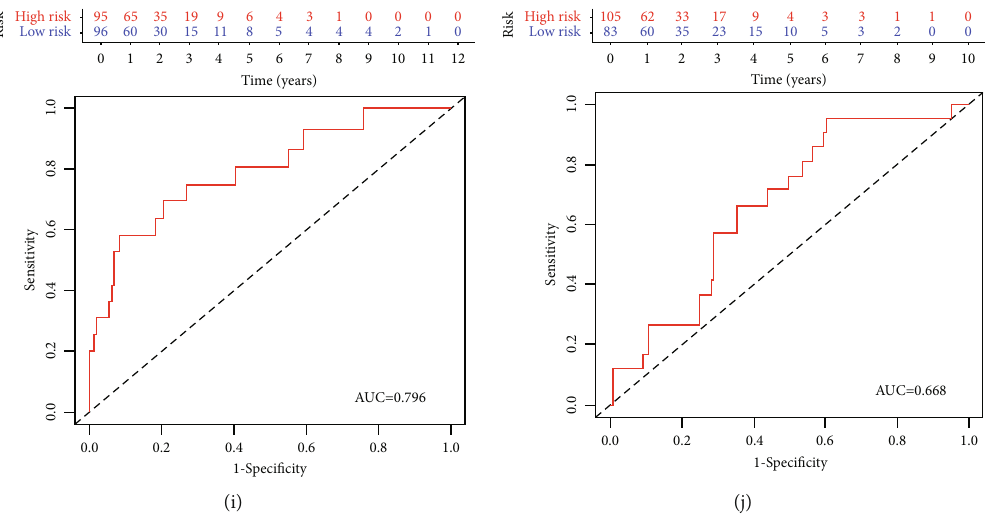
Figure 5: Construction and validation of prognostic signature of 15 ferroptosis-related lncRNAs in the training and testing cohorts. (a, b) Risk score distribution. (c, d) OS status. (e, f) Heatmaps. (g, h) The Kaplan-Meier curves for OS. (i, j) ROC